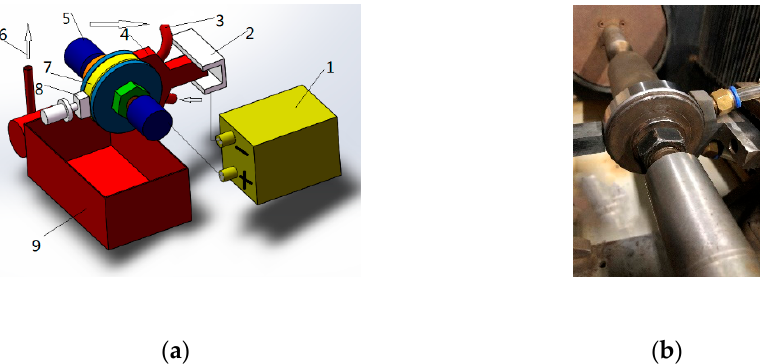
Figure 6. Experimental device: ( a ) schematic diagram, 1—power supply; 2—cathode plate; 3—pipeline; 4—cathode; 5—top; 6—electrolyte; 7—workpiece; 8—grinding tool; 9—electrolyte tank; ( b ) physical diagram.